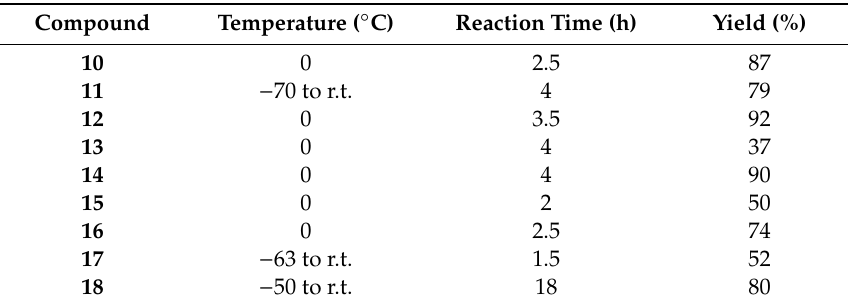
Table 3. Reaction conditions for disaccharides synthesis.